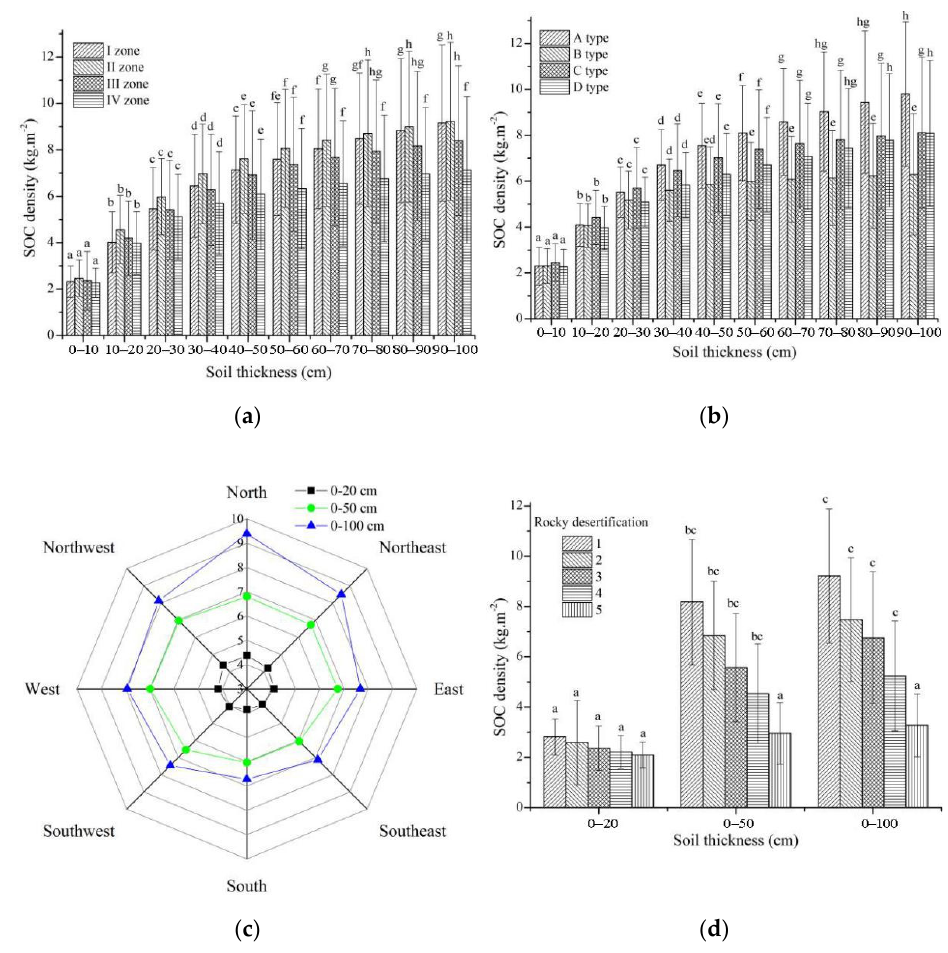
Figure 5. Information on SOCD spatial distribution characteristics: ( a – c ) show the SOCD at different slope positions, gradients and aspects; ( d ) shows the change trend of SOCD in several main soil layers during the rocky desertification process.